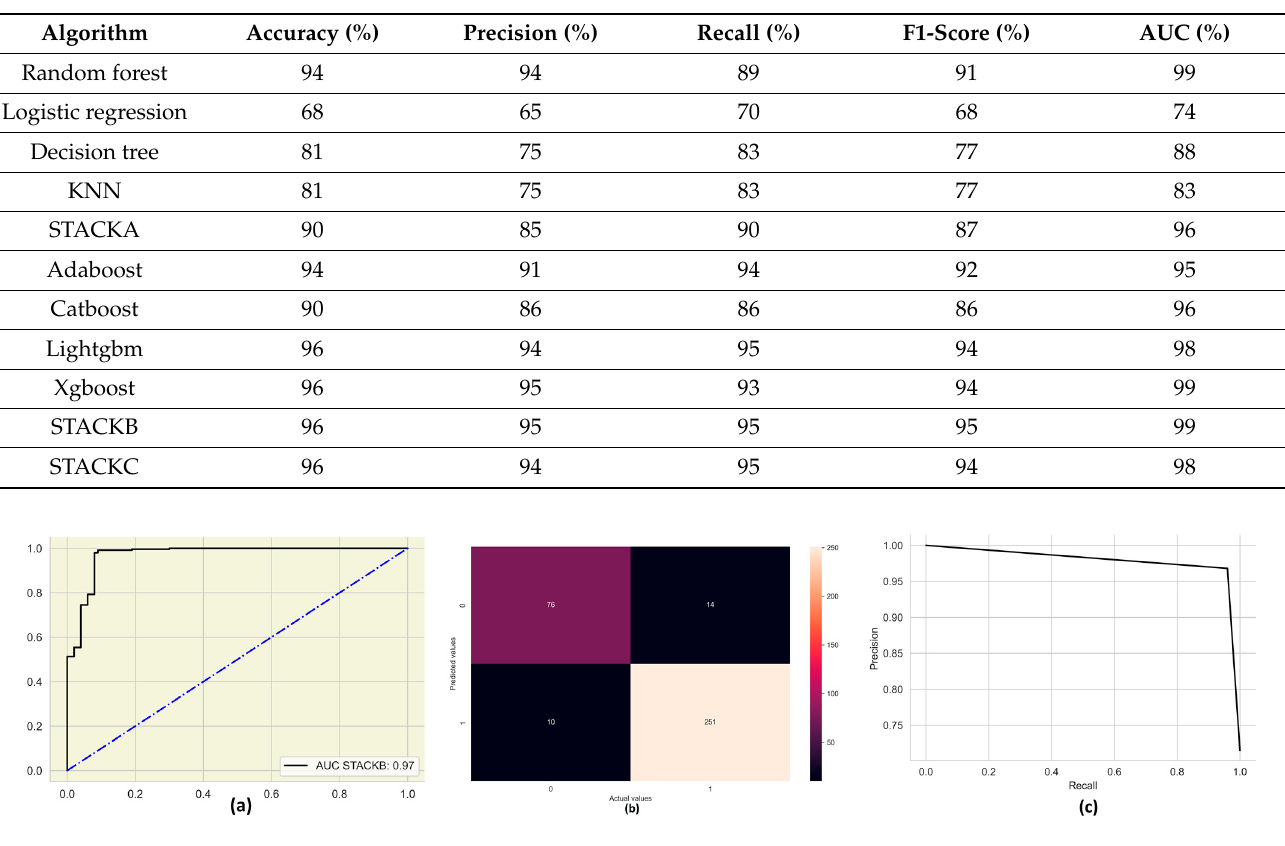
Table 4. Hyperparameters chosen by the algorithms.